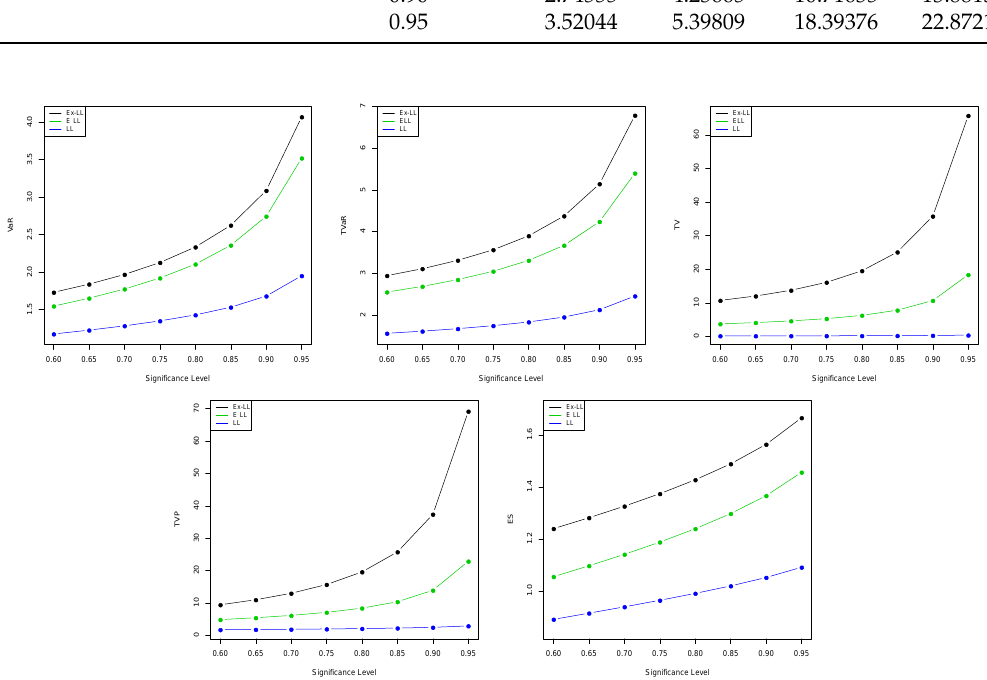
Figure 4. Shapes of the VaR, TVaR, TV, TVP, and ES using the numerical values in Table